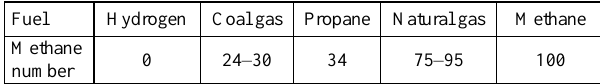
Table 2. Methane number of selected gaseous fuels [11, 12]